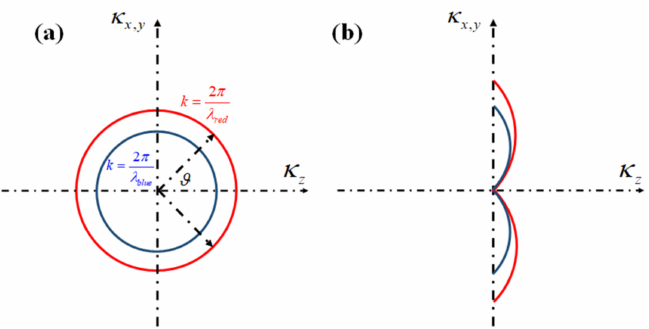
Figure 9. Filling of the Ewald’s sphere for 2 projections at different illumination wavelength (i.e., red and blue). ( a ) Transverse spatial frequencies plane at K z = 0. ( b ) K x (K y ),K z plane at K y ( K x ) = 0.